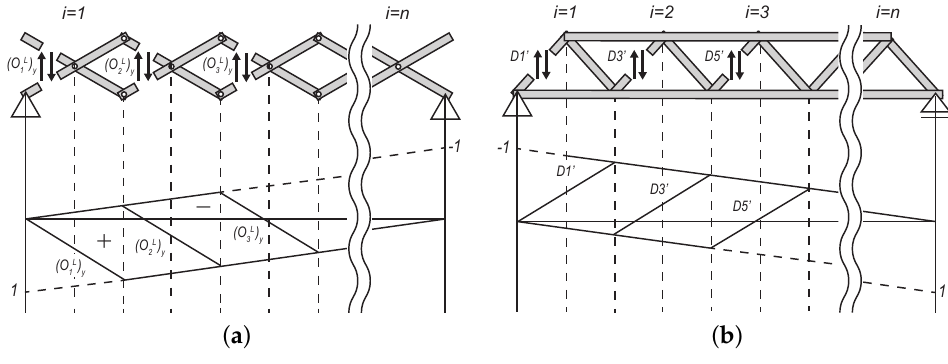
Figure 7. Comparison of examples of the I.L. ( a ) Sharing force for the scissors bridge. ( b ) Sharing force for a Warren truss